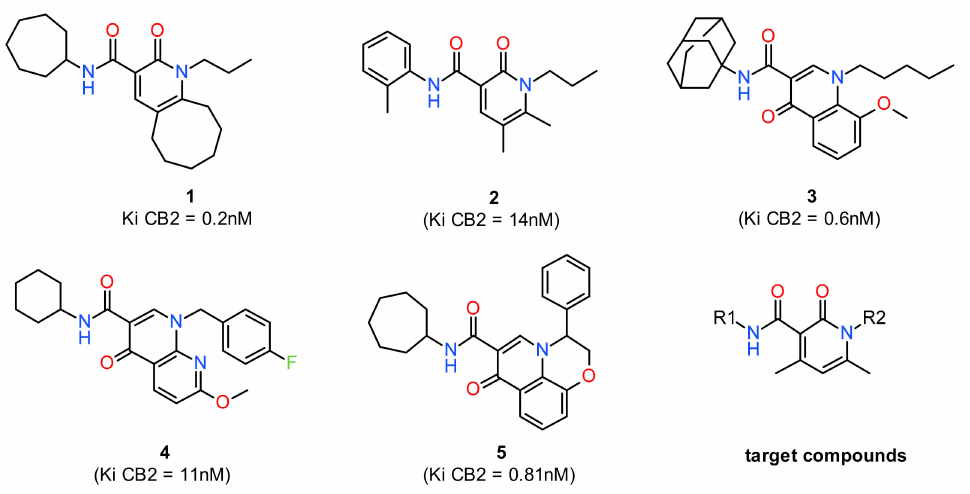
Figure 1. Chemical structures of reported pyridone/quinolone based CB2R ligands and target